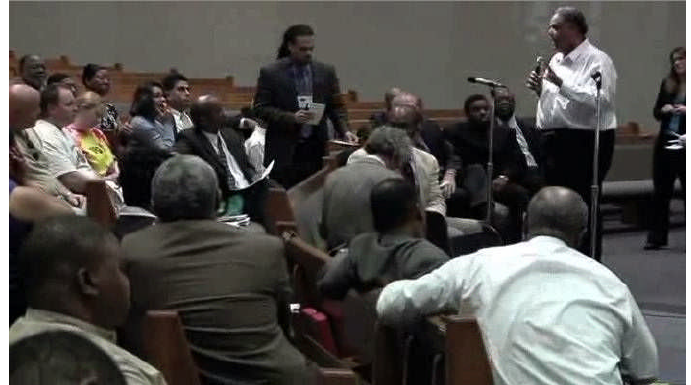
Figure 2: Third group: Sound Engineer and 2 meeting